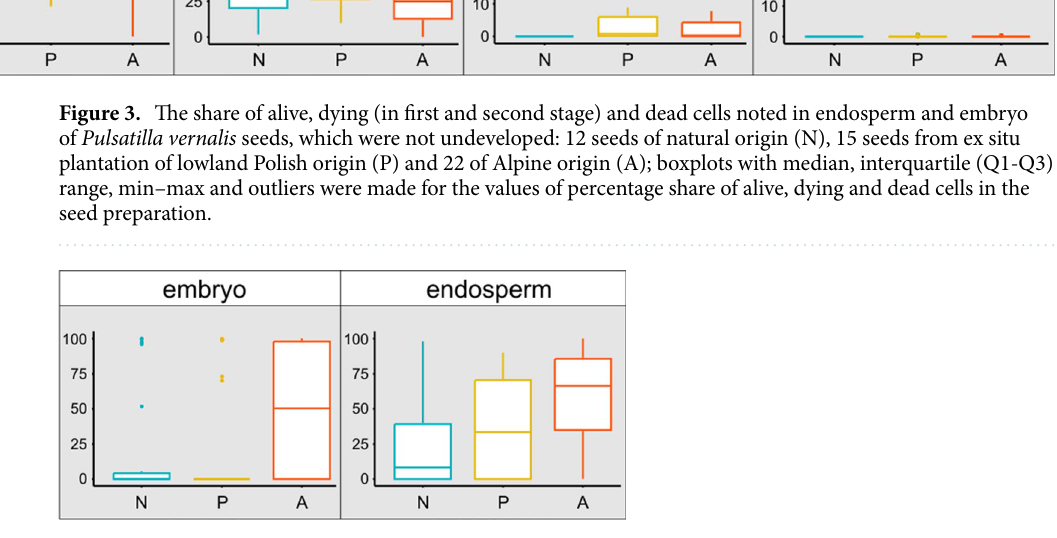
Figure 4. The share of alive cells noted in endosperm and embryo of Pulsatilla vernalis seeds counted on the samples of 22 seeds collected from natural site (N), and from ex situ plantation of Polish (P) and Alpine (A) origin; boxplots with median, interquartile (Q1-Q3) range, min–max and outliers were made for the values of percentage share of alive cells in the seed preparation.